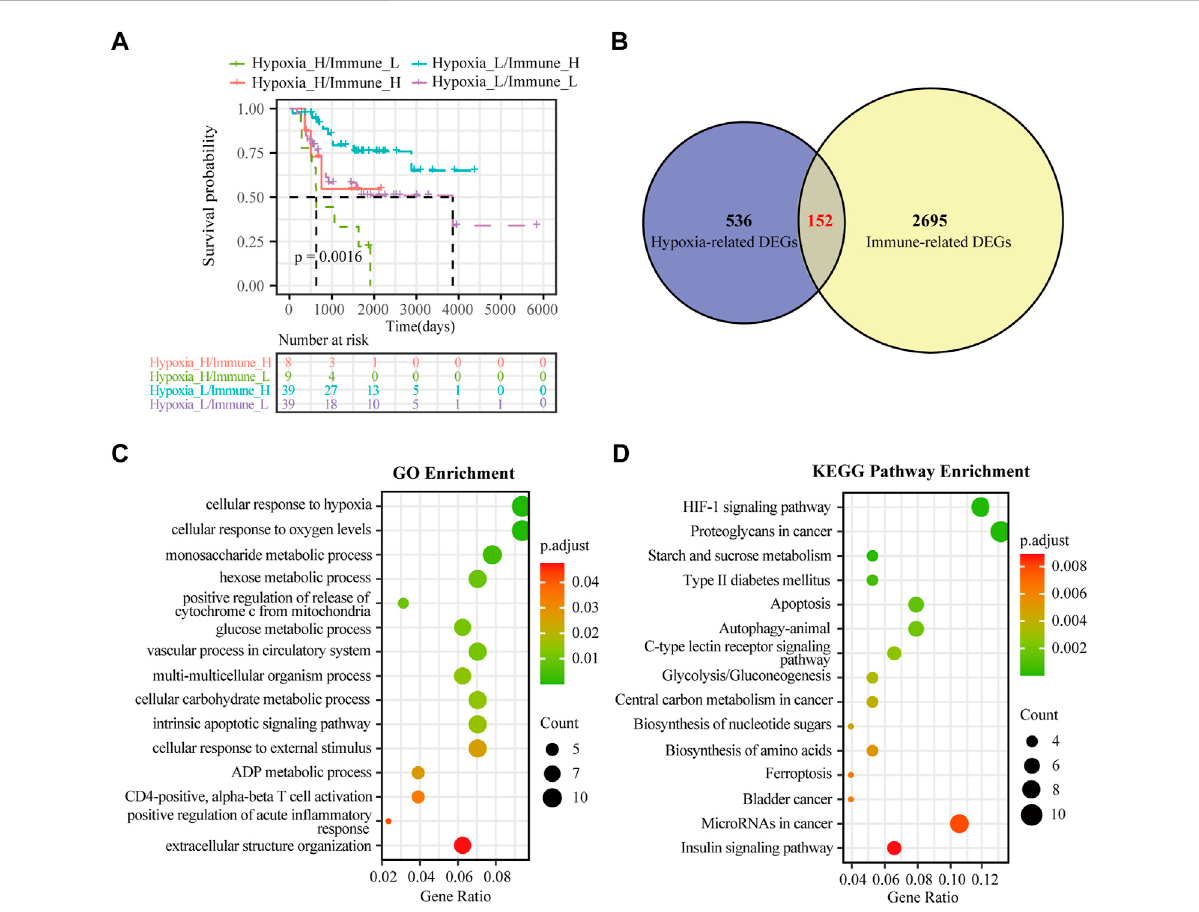
FIGURE 3 Identi fi cation of hypoxia-immune-related DEGs in osteosarcoma. (A) K-M plot of overall survival for patients in hypoxia-high/immune-low, hypoxia-low/immune-high, hypoxia-high/immune-high and hypoxia-low/immune-low group in the TARGET dataset. (B) Venn diagrams showing overlaps of hypoxia-related DEGs and immune-related DEGs in the TARGET dataset. (C) GO analysis for hypoxia-immune-related DEGs in the TARGET dataset. (D) KEGG analysis for hypoxia-immune-related DEGs in the TARGET